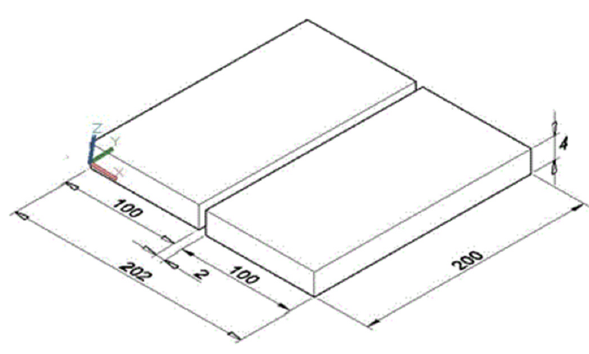
Fig. 1. Butt joint design for two sheetsall dimensions in mm.